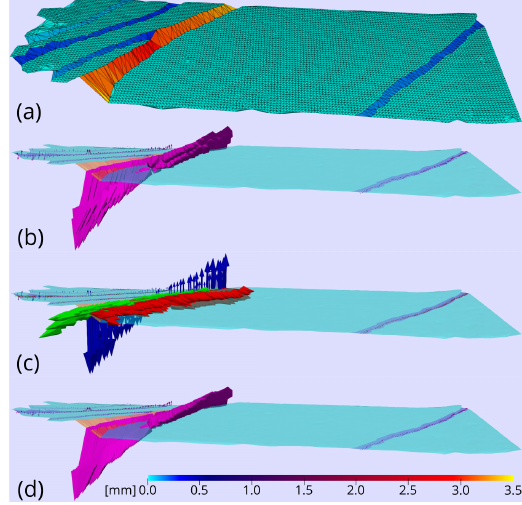
Figure 12. (a) Color-coded mesh of || ⃗t rel, 2 D || (deformed state); (b) deformation vectors with the model of parallel translation; (c) decomposition of the deformation vectors to crack normal (red), shear (green), vertical component (blue); (d) deformation vectors with the model extension for relative rotation (scale factor: 5 for (b),(c),(d)).